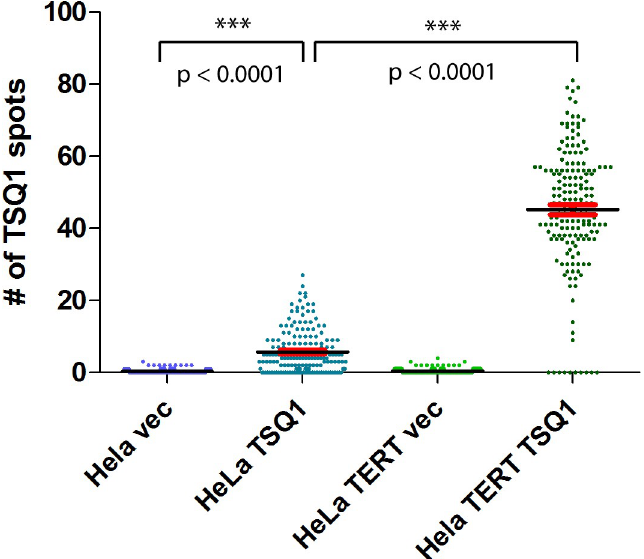
Fig 4. Quantification of TERT expression and telomere elongation in single cells. Swarm plots showing the number of TSQ1 spots co-localizing with telomeres in HeLa cells and HeLa cells overexpressing TERT. 171 cells from at least 2 separate experiments were assayed for each group. Means (horizontal black lines) and SEM (red lines) are shown for each population. P values (Mann-Whitney test) are provided and significant differences are marked with asterisks.